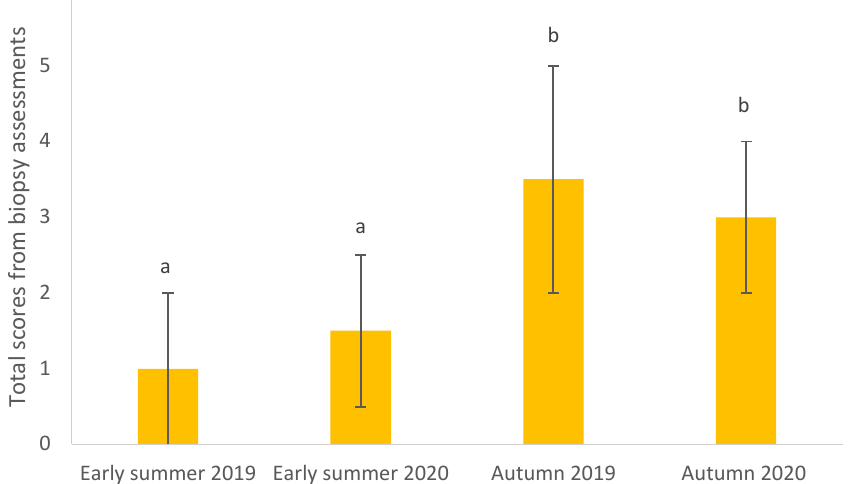
Figure 2. Total scores (least square mean ± standard error) of skin inflammation markers in skin biopsies collected from eight horses with insect bite hypersensitivity (IBH) in 2019 and 2020. Different letters (a, b) indicate significant differences between seasons ( p < 0.05).